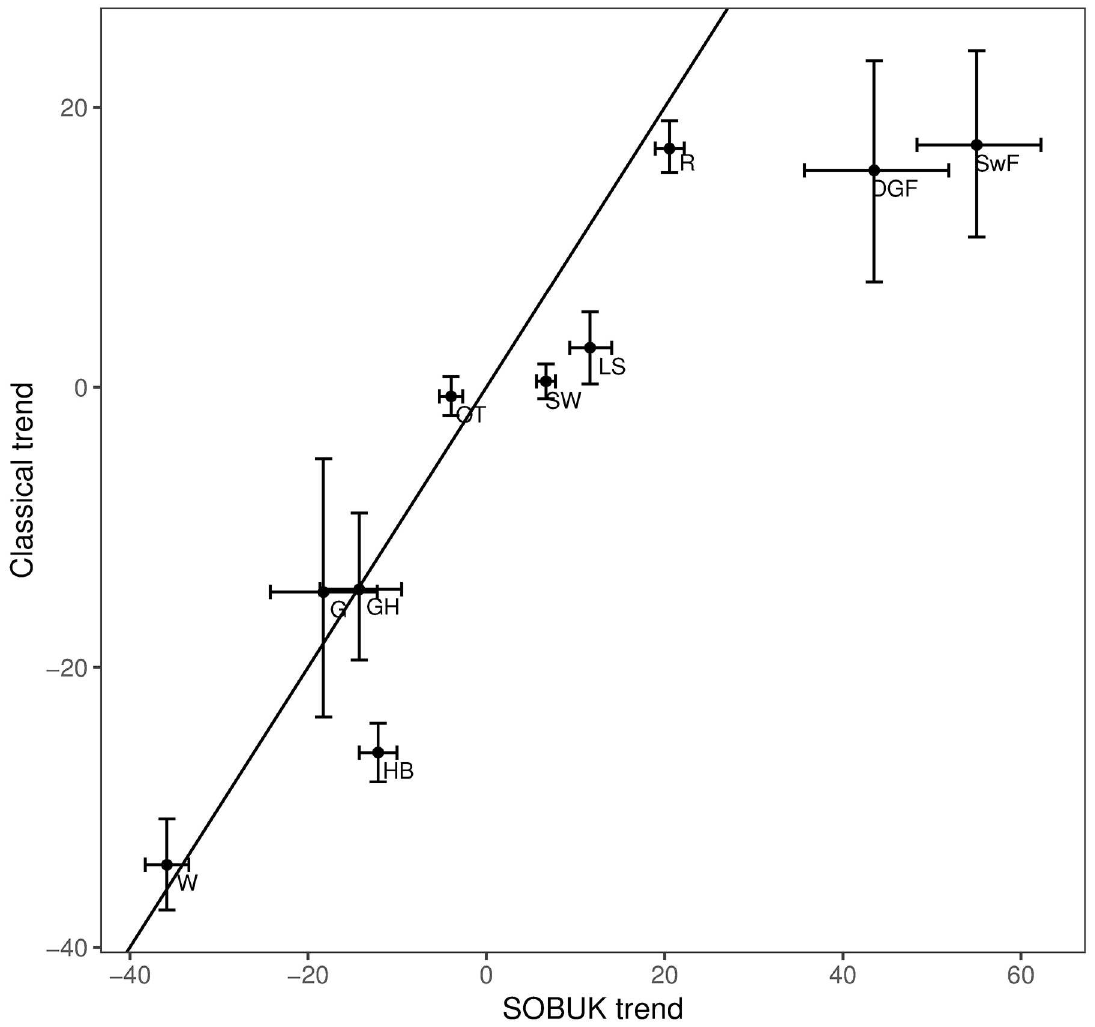
Fig 4. Trend comparison for models B and C. Trend comparisonfor 2005-2014from model C and the trend from [15]—the State of UK Butterflies 2015 (SOBUK). Speciescodes are definedin Table A in S1 File. The 95% confidencebars for model C and result from the approximate bootstrapapproach, while for model B we use the results of [15].